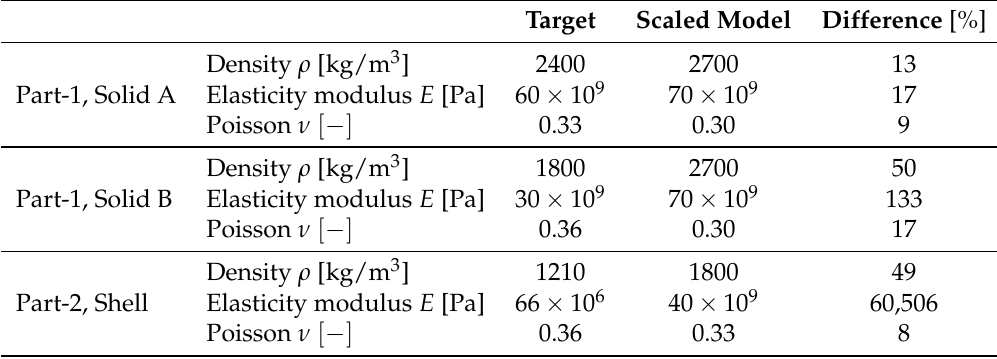
Table 3. Comparison between the material properties of the target and scaled models for Cases 3 and